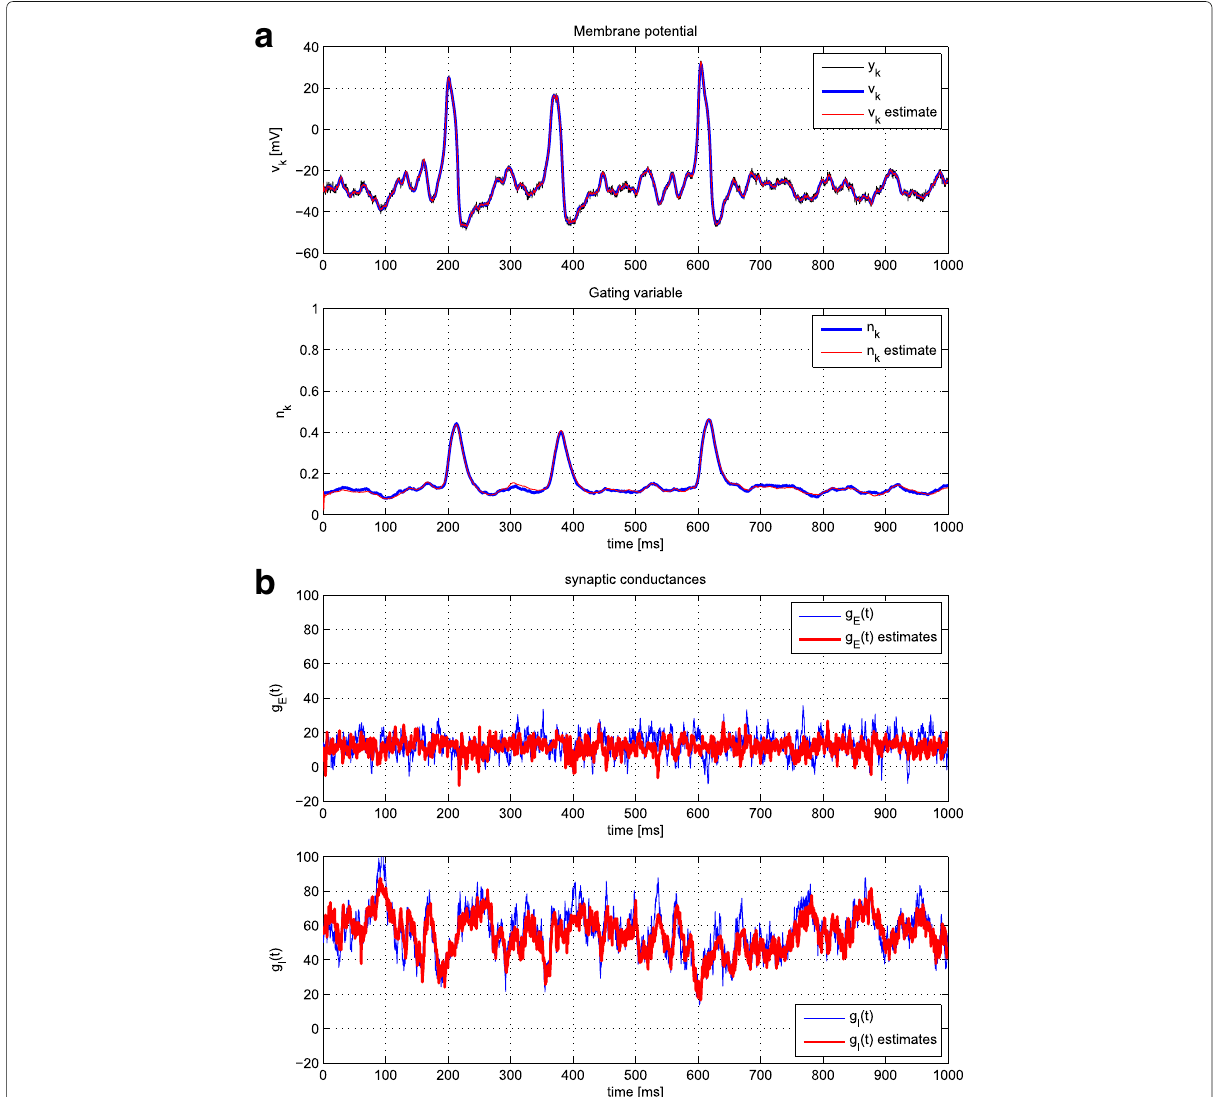
Fig. 9 A single realization of the PMCMC method, estimating voltage and gating variables ( a ) and synaptic conductances in nS ( b ) as well as model parameters. See Table 3 for the true value, initial value, and covariance of the parameters used here